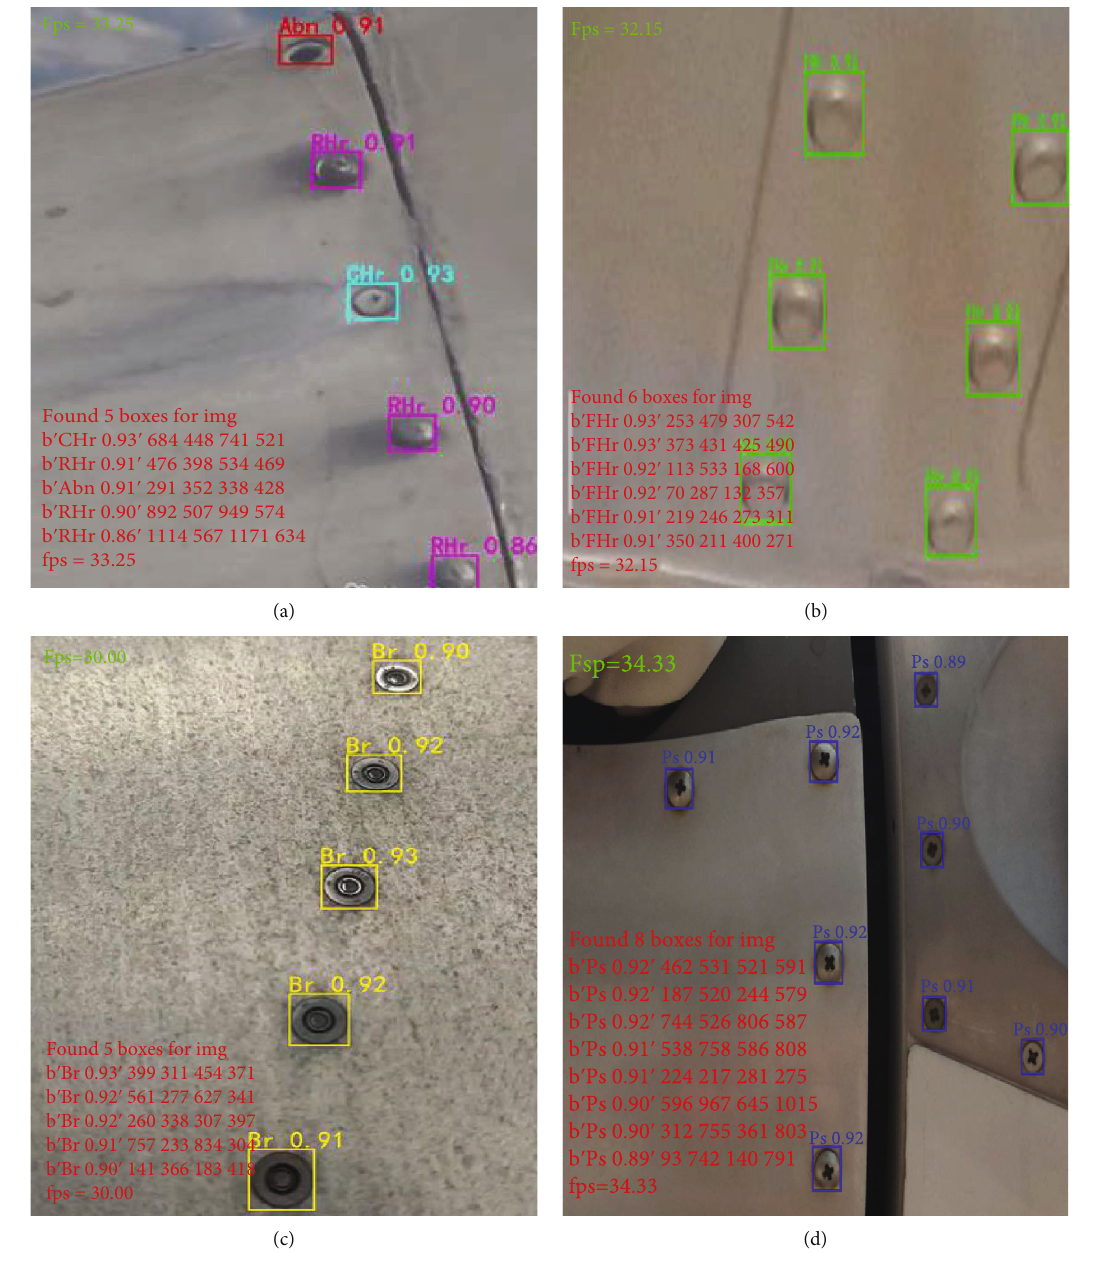
Figure 5: Target detection results of aviation rivets. Table 2: Accuracy, recall rate, and AP value of di ff erent types of